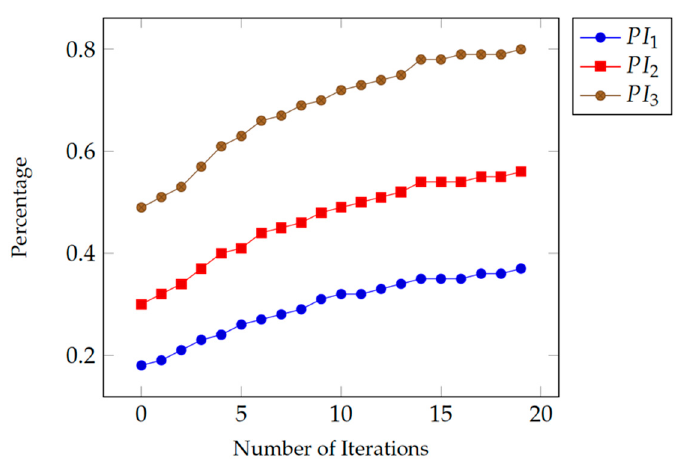
Figure 3. Different values for the performance index, by implementing Equation (9). The lower line presents a static value of C = 3 and I = 7. The mid-line presents an equal value for C = I = 5. The upper line presents the values of C = 8 while I = 2.